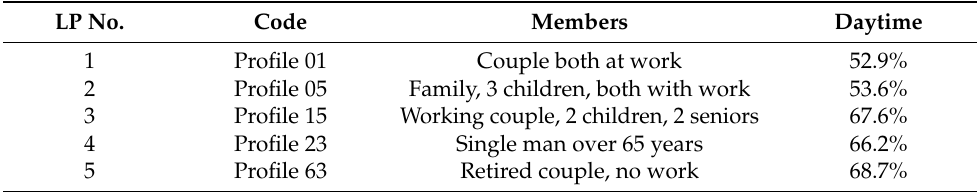
Table 2. Load profiles (LPs) considered for the computational